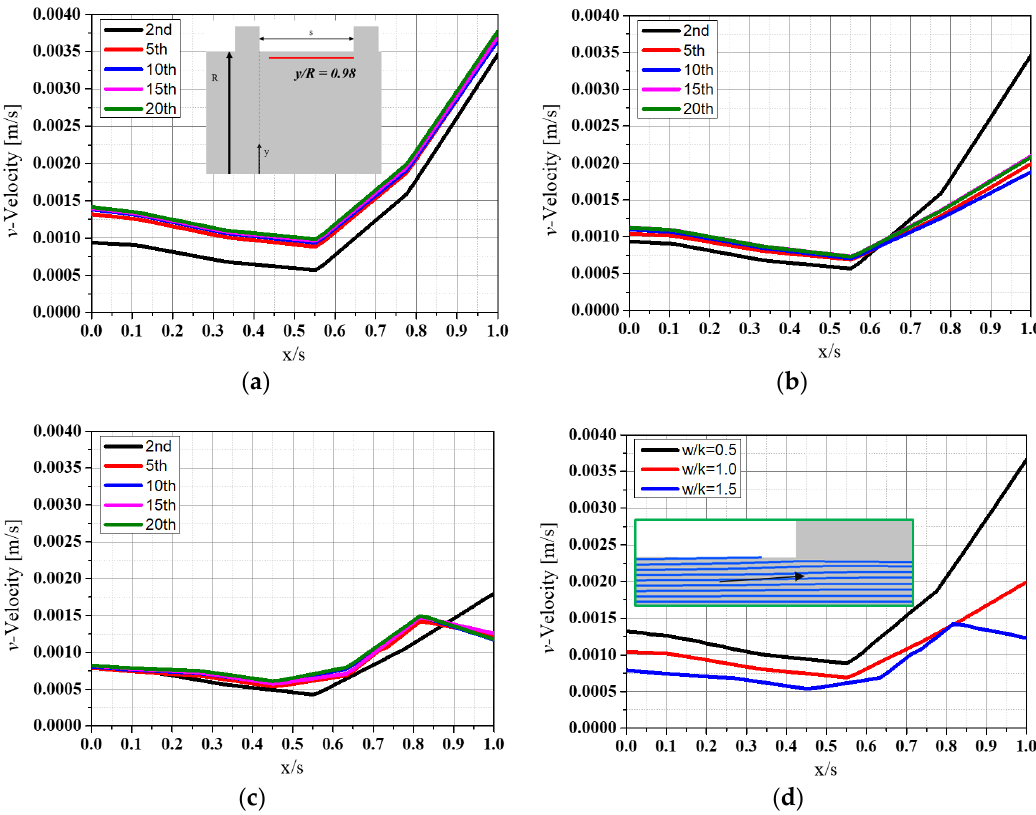
Figure 8. v -velocity distribution at y/R = 0.98 for different w / k ; ( a ) v -velocity distribution at the different groove, for w / k = 0.5, ( b ) v -velocity distribution at the different groove, for w / k = 1.0, ( c ) v -velocity distribution at the different groove, for w / k = 1.5 ( d ) Comparison v -velocity distribution at y/R = 0.98 for different w / k.